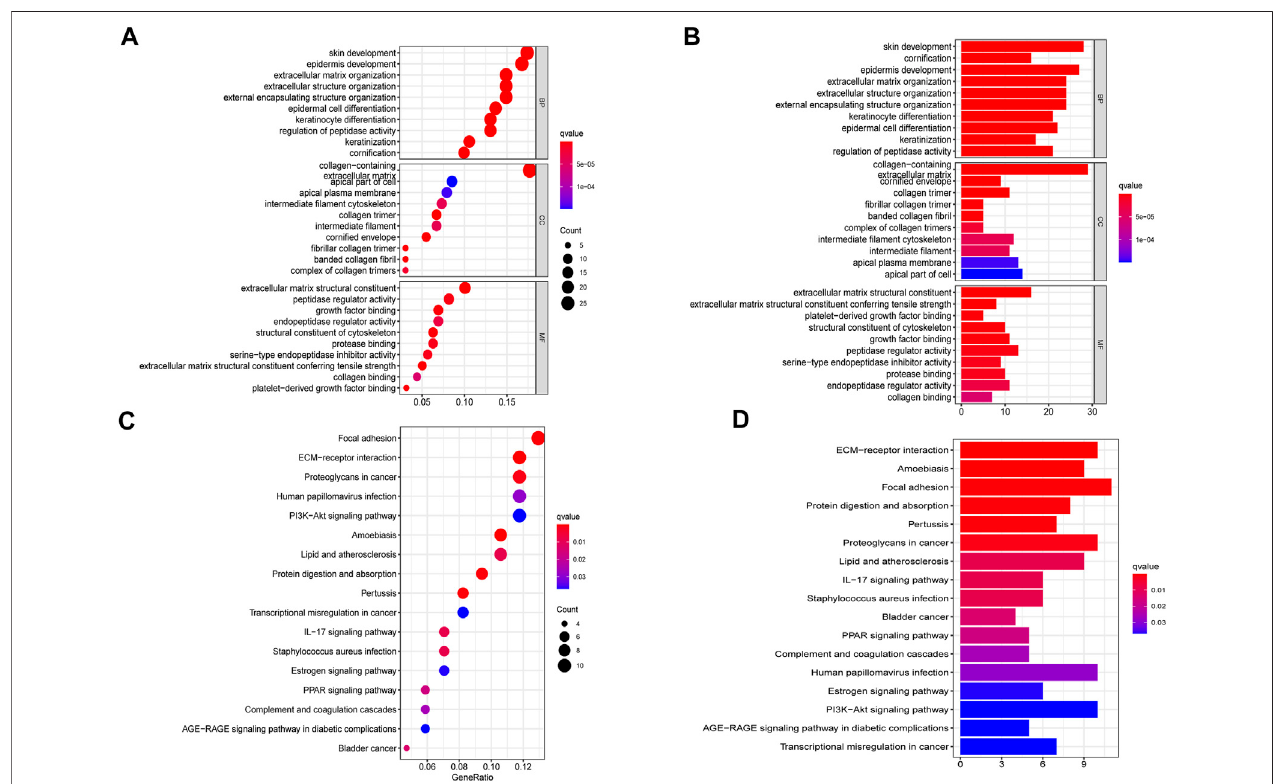
FIGURE 6 | Gene set enrichment analysis of pathways and biological functions based on TCGA cohort. (A,B) GO, Gene Ontology. (C,D) KEGG, Kyoto Encyclopedia of Genes and Genomes.